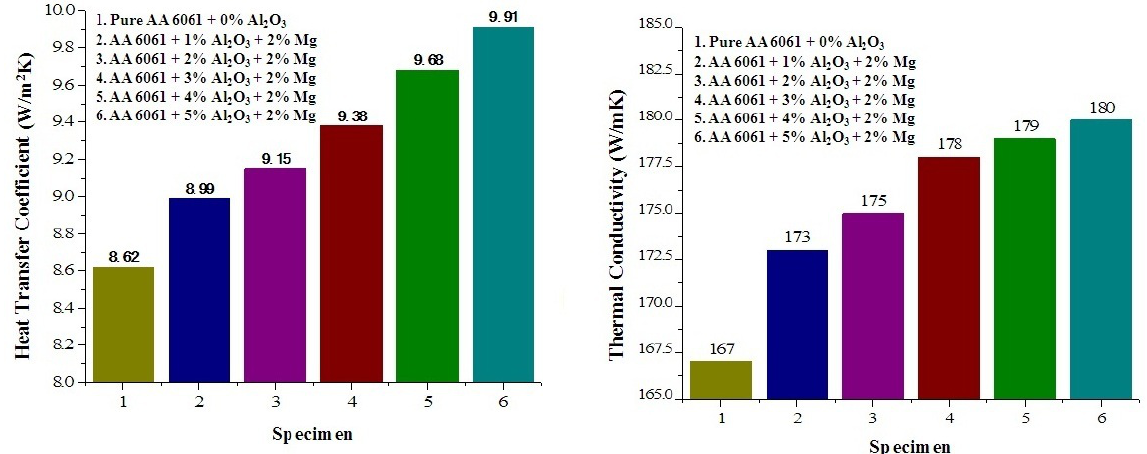
Figure 4: Thermal Properties of Al/Al 2 O 3 composites with pure AL6061 through Pin-Fin